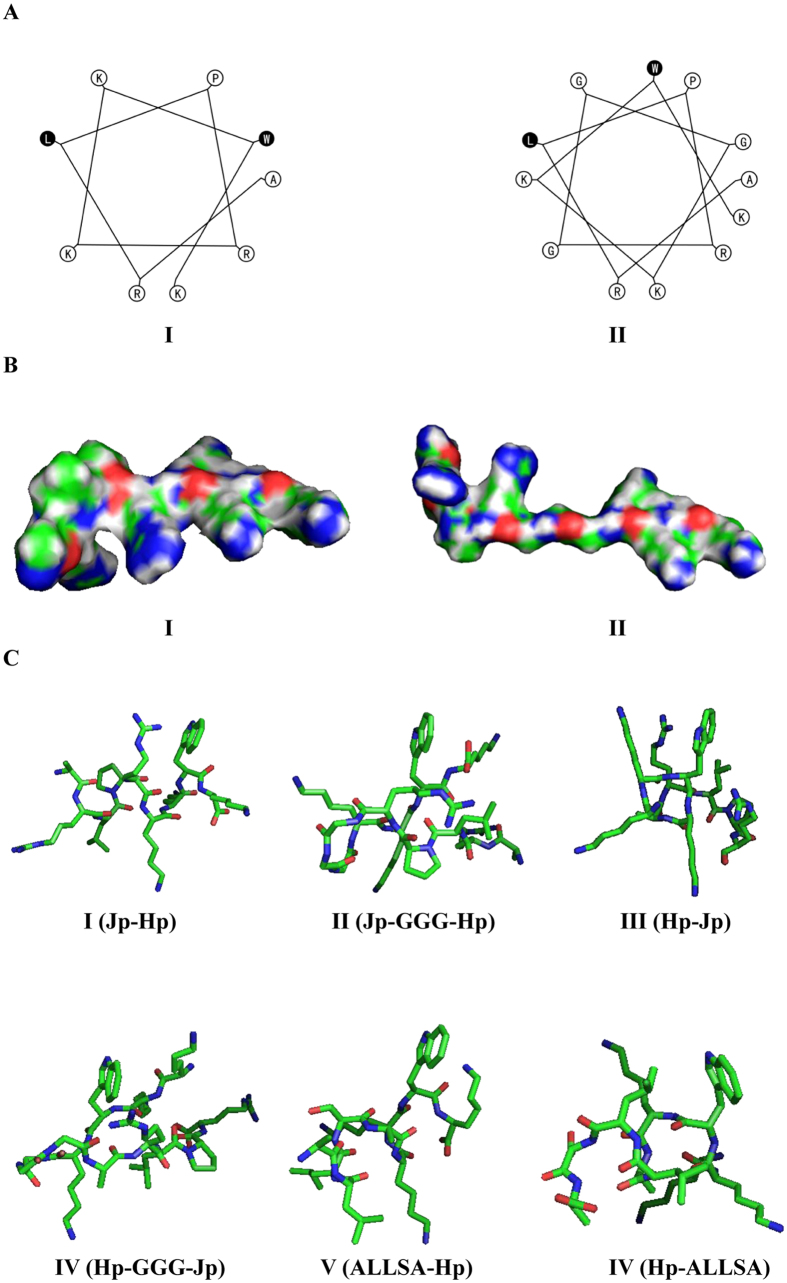
(A) The helical wheel projection of peptide Jp-Hp and Jp-GGG-Hp, with hydrophobic residues shaded. (B) Predicted 3D structures of Jp-Hp and Jp-GGG-Hp. The calculation of 3D structure was based on the web tool at: http://bioserv.rpbs.univ-paris-diderot.fr/PEP-FOLD/; (C) is the 3D structure of selected peptides, where the possible intramolecular interactions between the guanidinium group of argnine and the indole ring of tryptophan were observed in peptides C20-Jp-Hp (I) and C20-Hp-Jp (III), while these interactions were absent in other peptides. For all peptides in (A–C), the number of I to VI refers to peptides Jp-Hp (I), Jp-GGG-Hp (II), Hp-Jp (III), Hp-GGG-Jp (IV), ALLSA-Hp (V) and Hp-ALLSA (VI), respectively.